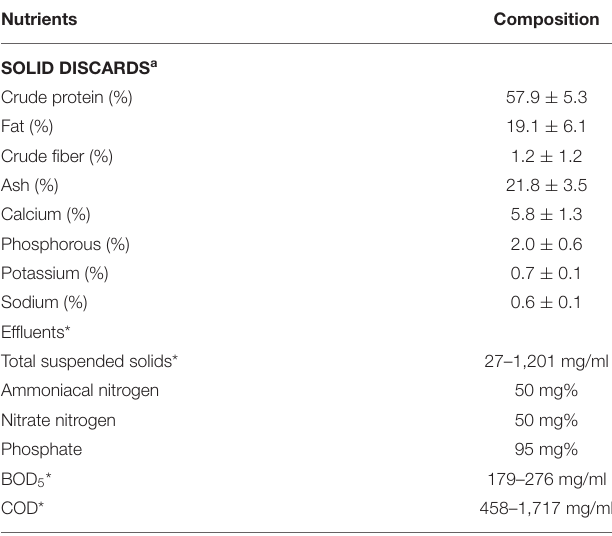
TABLE 1 | Major components of seafood processing